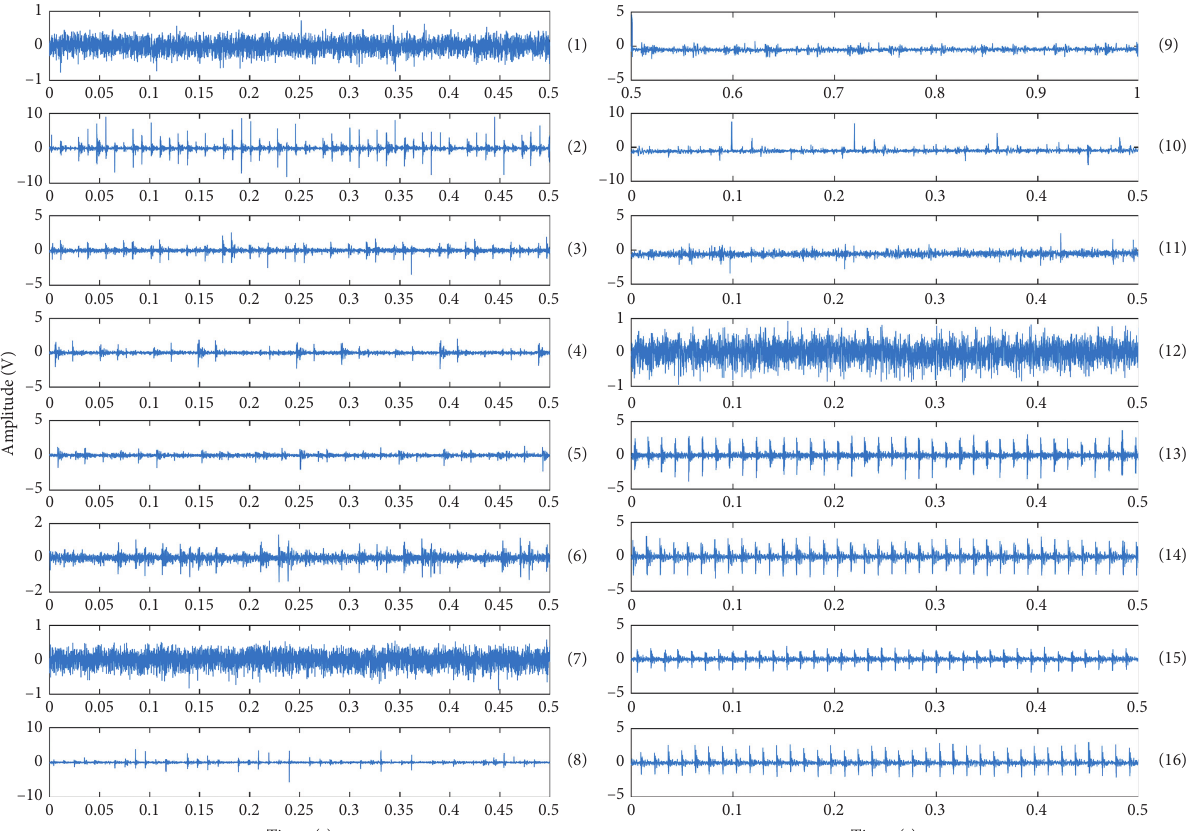
Figure 5: Vibration signals for different bearing health conditions. (1) Norm, (2) IF: 0.2mm, (3) IF: 0.3 mm, (4) IF: 0.4mm, (5) IF: 0.5mm, (6) IF: 0.6mm, (7) BF: 0.2 mm, (8) BF: 0.3 mm, (9) BF: 0.4 mm, (10) BF: 0.5mm, (11) BF: 0.6mm, (12) OF: 0.2 mm, (13) OF: 0.3mm, (14) OF: 0.4mm, (15) OF: 0.5mm and (16) OF: